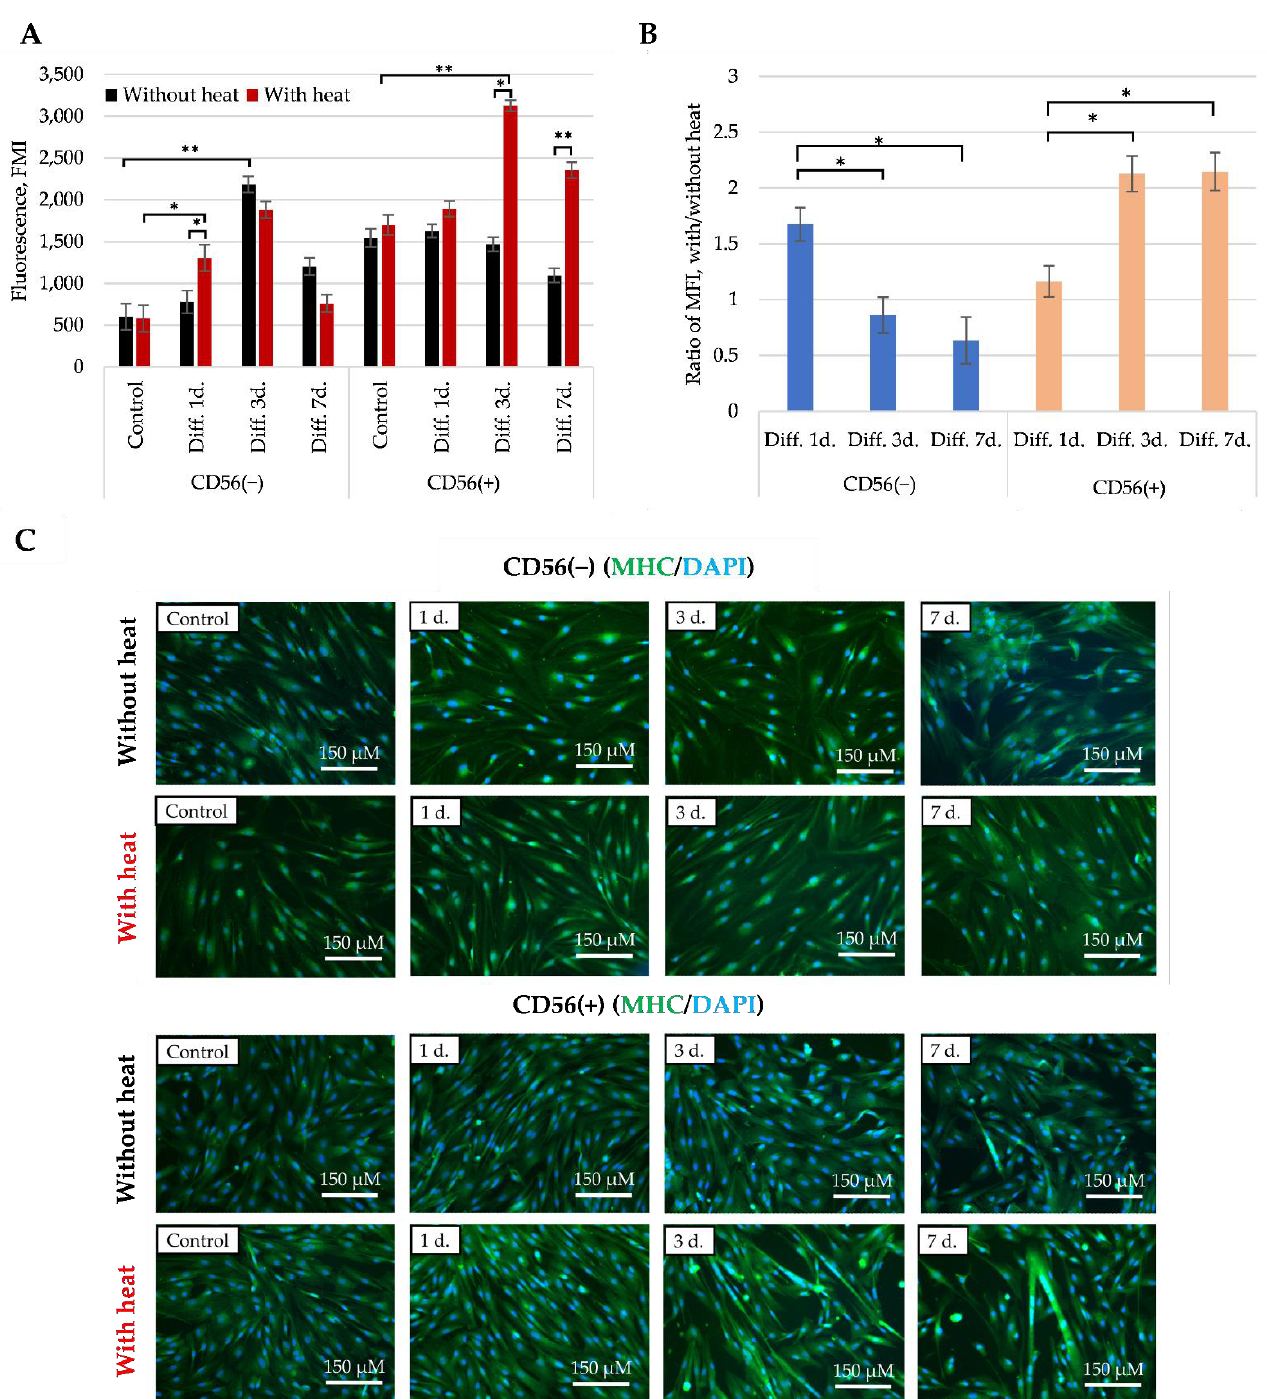
Figure 9. The effect of heat stimulus on the MHC1 level in CD56( − ) and CD56(+) cells. The level of MHC1 in CD56( − ) and CD56(+) cells was estimated by flow cytometer measuring median fluorescence intensity (MFI) ( A ) and MFI ratio of heat stimulated versus not stimulated cells ( B ). ( C ). The impact of heat stimulus on the MHC1 level and formation of multinucleated cells estimated by fluorescent immunocytochemistry. Data are shown as mean ± standard deviation (SD) and are significant at * p ≤ 0.05 and ** p ≤ 0.01 levels from not less than three repeats ( n = 3) and two cell cultures calculated using the Excel software. MHC–myosin-heavy chain 1. Cell fluorescence was visualized with EVOS M7000